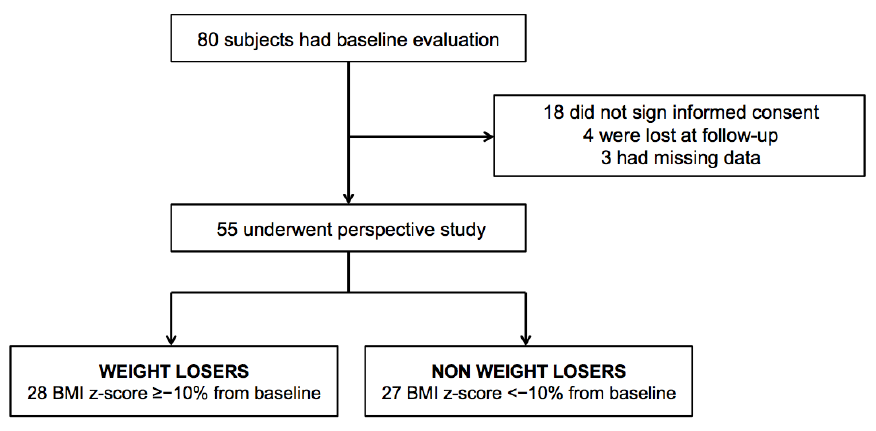
Figure 1. Longitudinal study flow diagram.